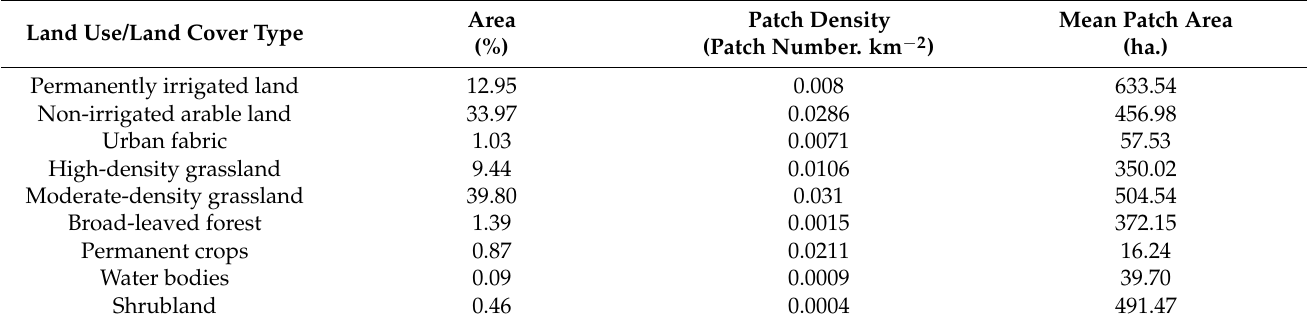
Table 3. Results of the landscape composition metrics for the study catchments.